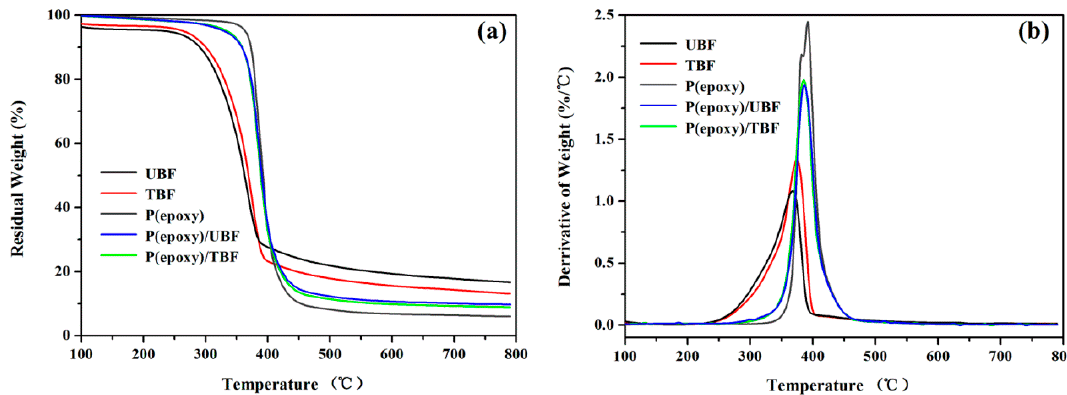
Figure 12. TGA ( a ) and DTG ( b ) curves of untreated and 6 wt.% NaOH treated bamboo fibers, neat epoxy and their composites. Table 2. TGA summary for bamboo fibers, neat epoxy and bamboo/epoxy composites.